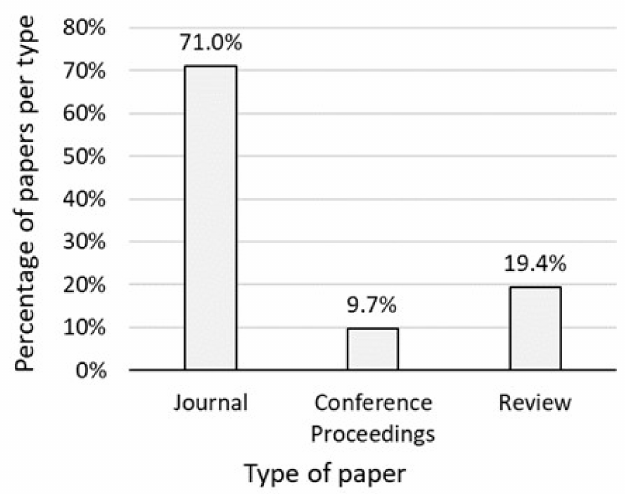
Figure 3. Percentage of papers per type.